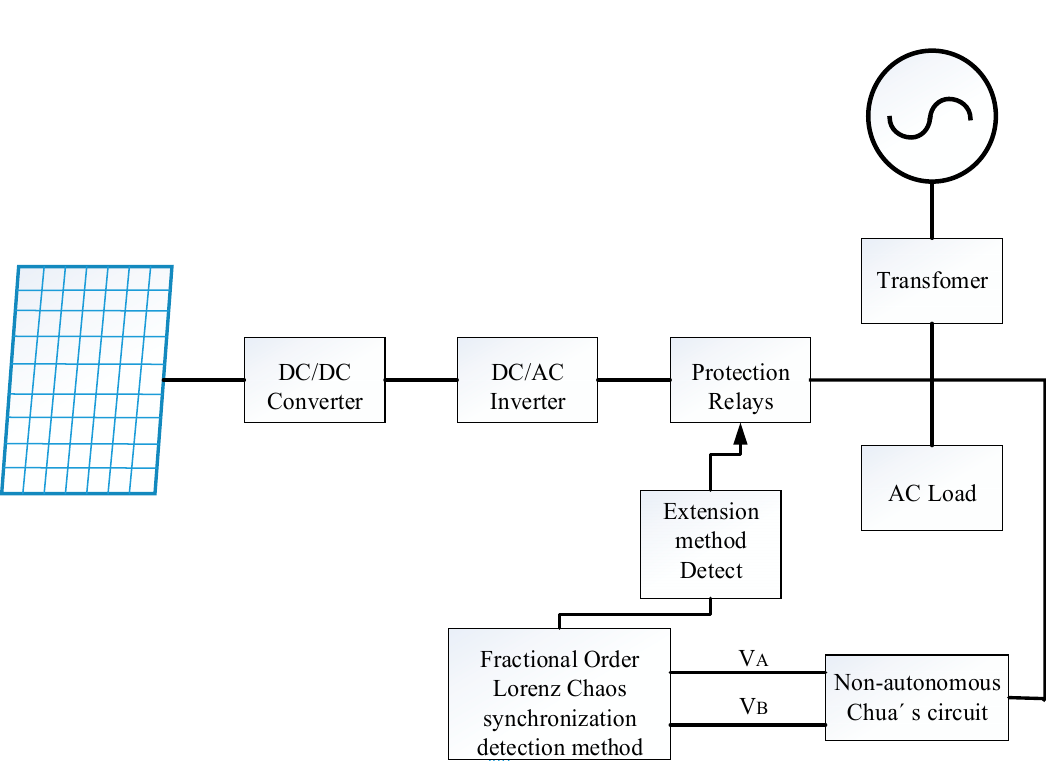
Figure 4. Grid-connected network using a Chua’s non-autonomous circuit.